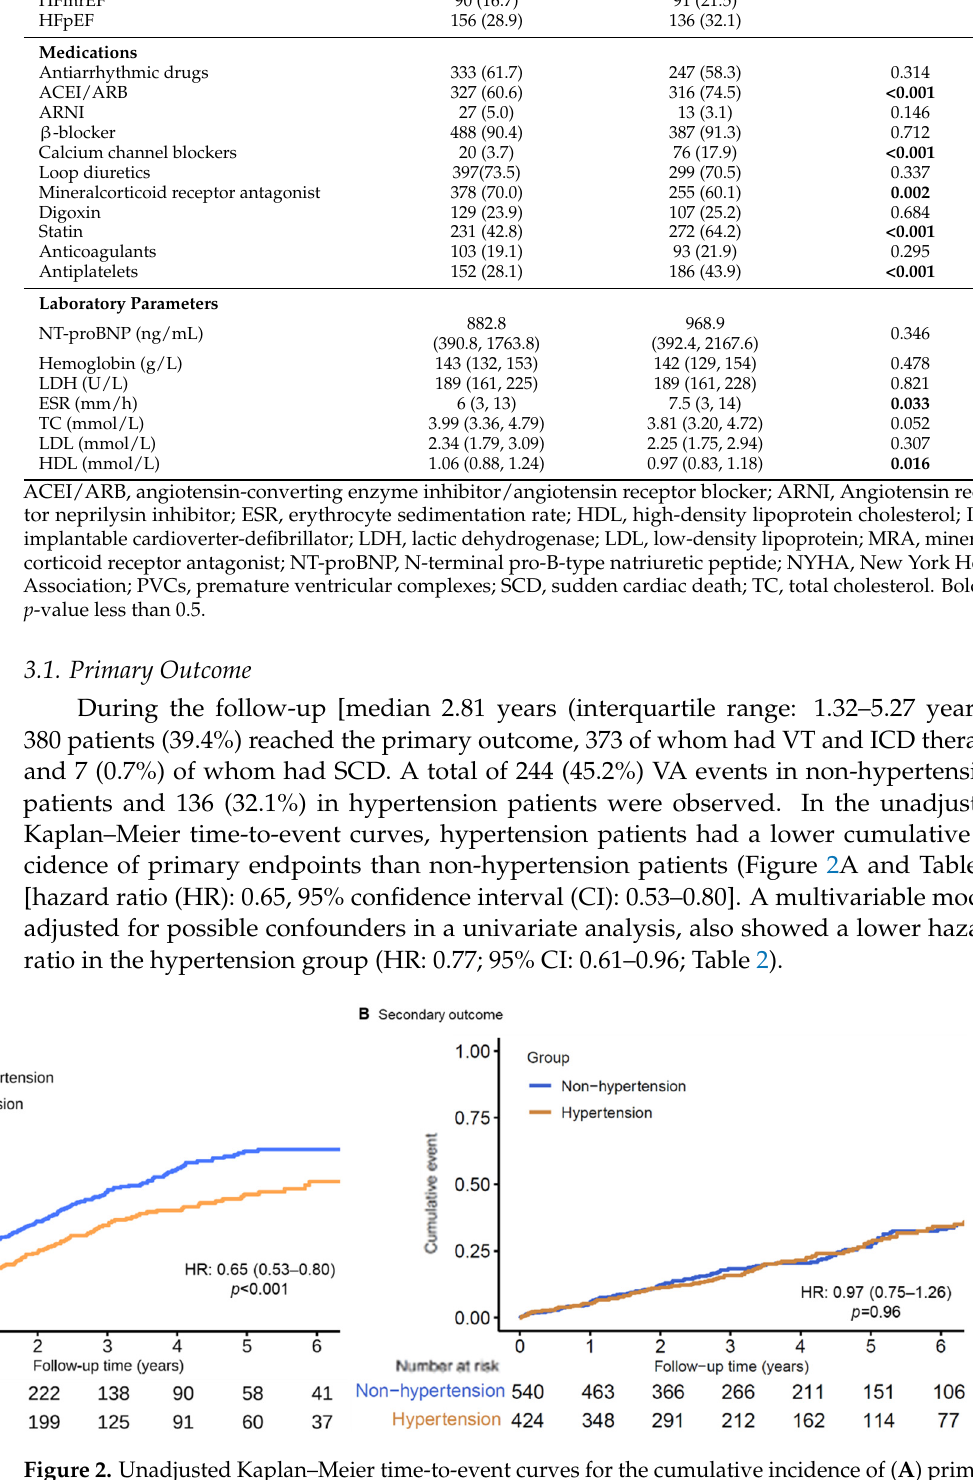
Figure 2. Unadjusted Kaplan–Meier time-to-event curves for the cumulative incidence of ( A ) primary and ( B ) secondary outcome events for patients with and without hypertension. Table 2. Associations between Hypertension diagnosis and the primary composite endpoint of VA and all-cause mortality in the crude analysis, multivariable analysis, propensity-score analysis, and entropy-balanced analysis.